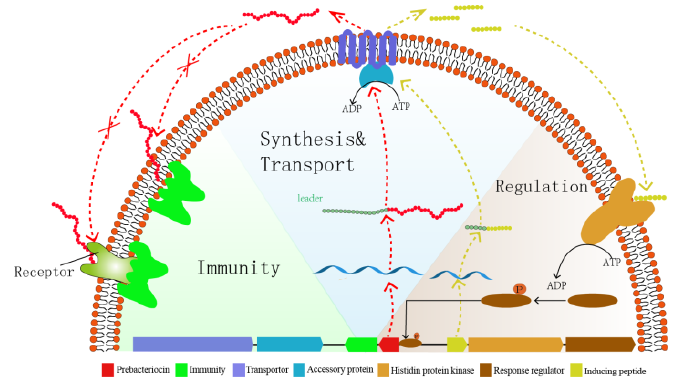
Figure 1. A schematic diagram of the biosynthesis of class IIa